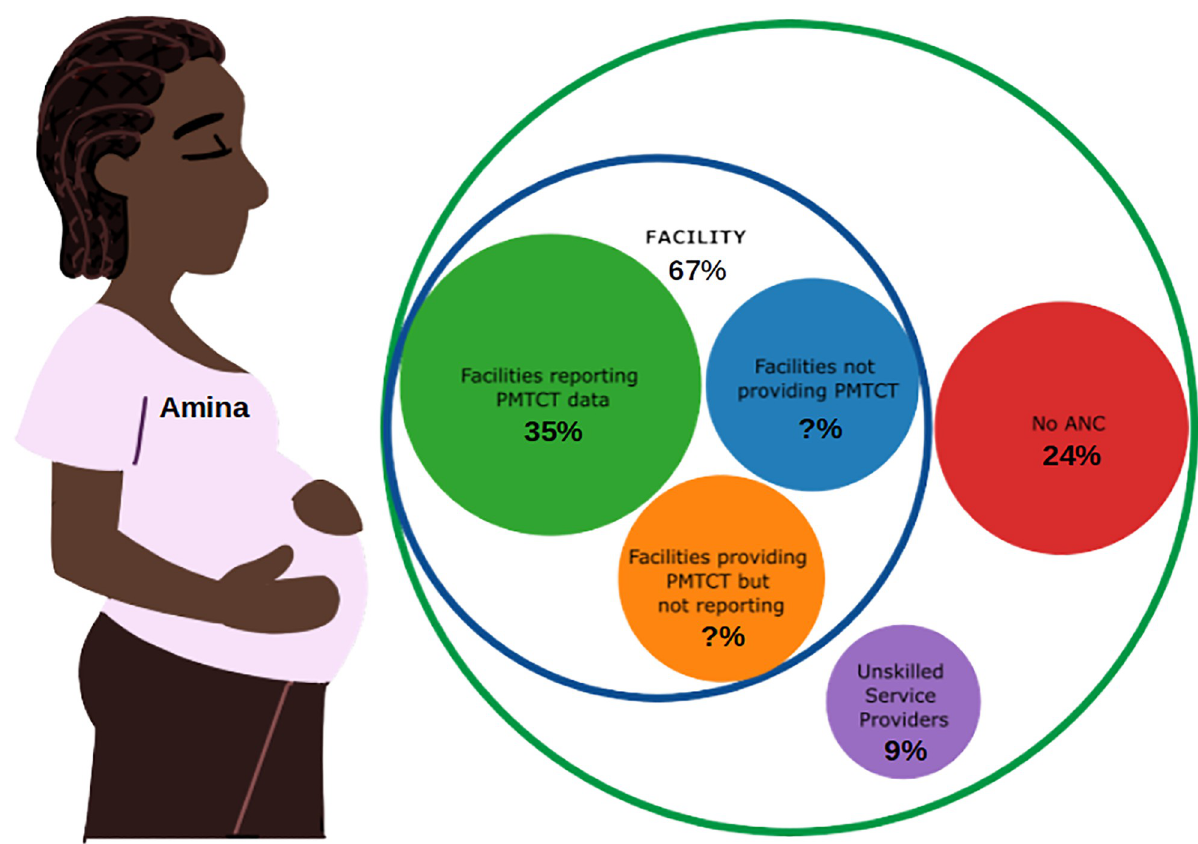
Fig 4. Packed circles showing antenatal care coverage from where pregnant women receive